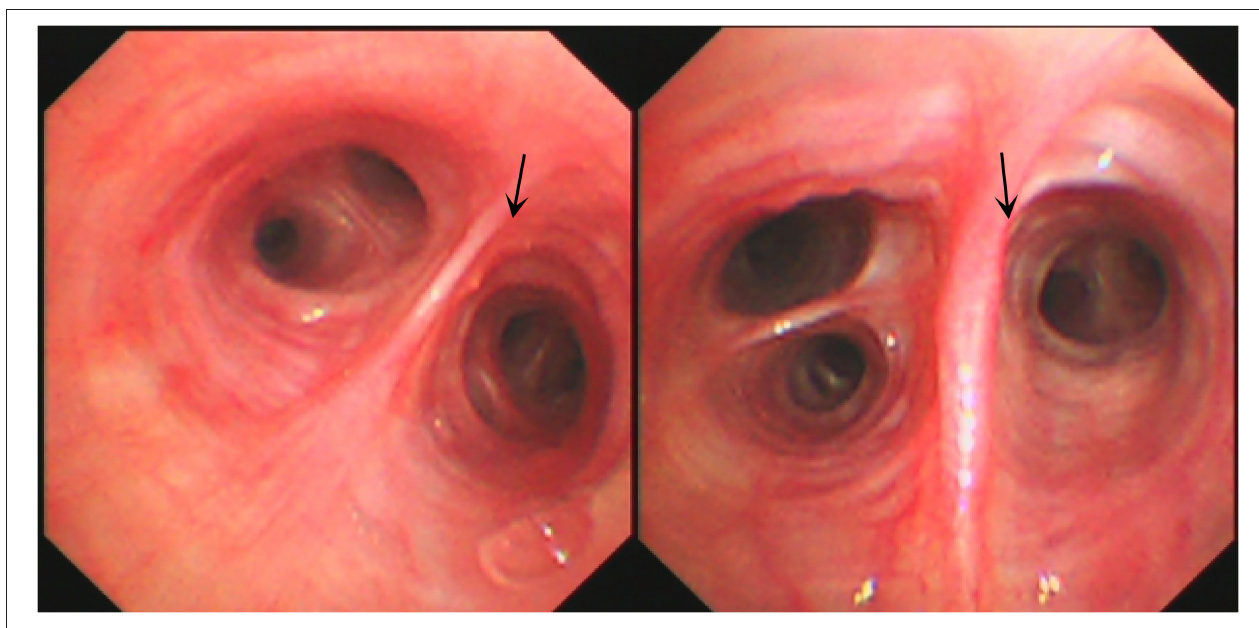
FIGURE 2 | Bronchoscopic image on November 17th (left) and 20th (right) , 2020.